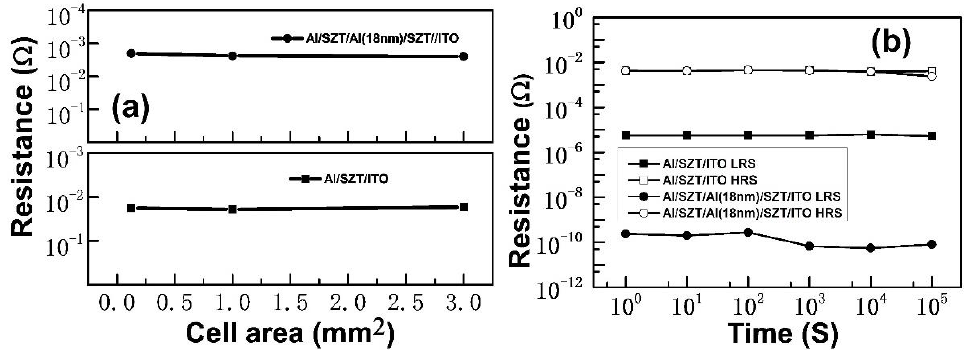
Figure 9. ( a ) LRS current with cell sizes ranging from 0.125 mm 2 to 3 mm 2 and ( b ) retention capability of Al/SZT/ITO and Al/SZT/Al (18 nm)/SZT/ITO structures.